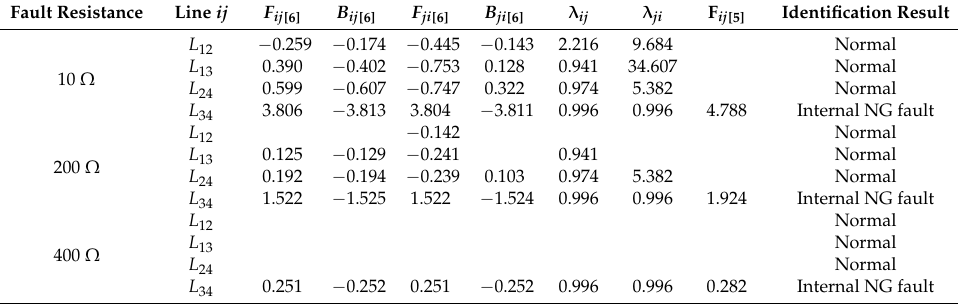
Table 5. Simulation results of modulus maxima with different fault resistances at f 2 fault. Fault Resistance Line